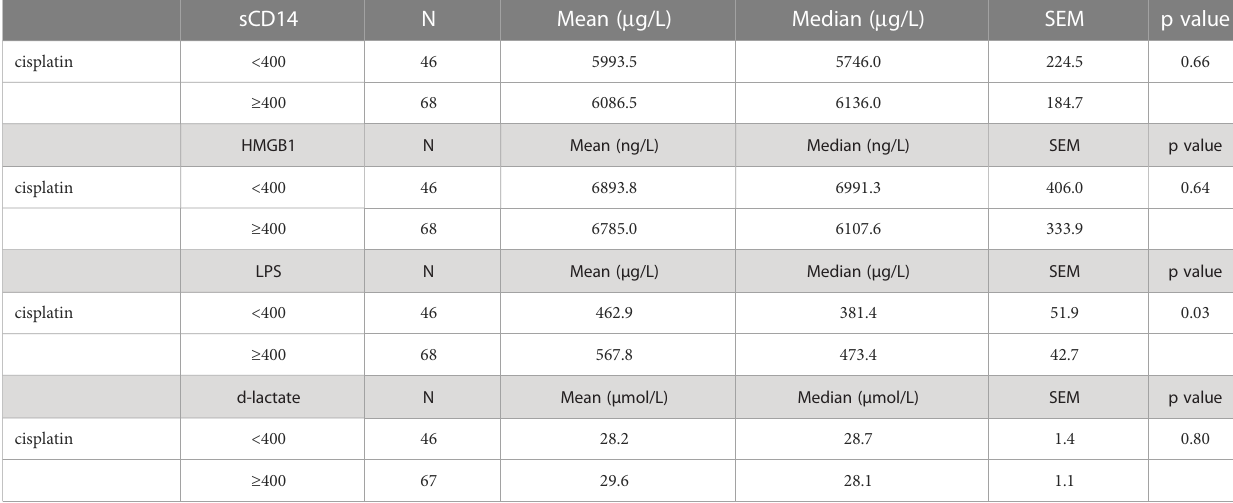
TABLE 3 Biomarkers of gut microbial transfer and their associations with received dose of